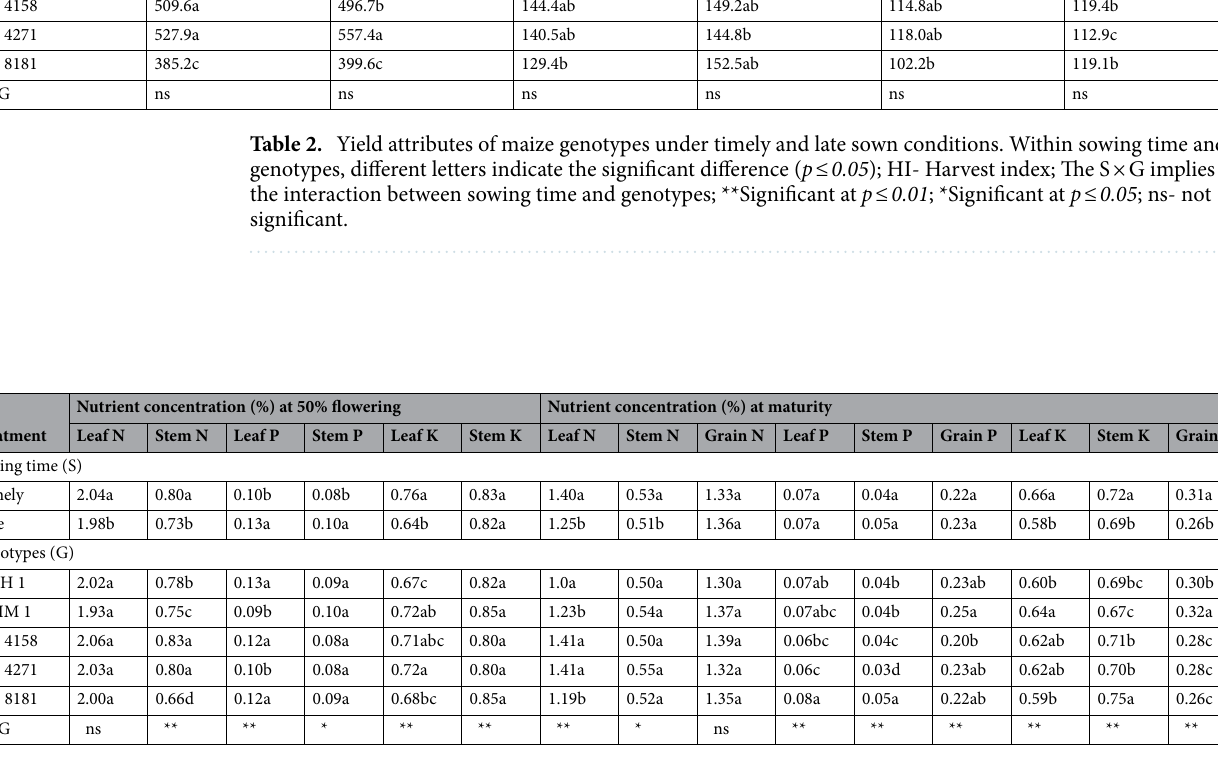
Table 3. Nutrients concentration in different plant parts of maize genotypes at 50% flowering and at maturity under timely and late sown conditions. N: Nitrogen, P: Phosphorus, K: Potassium. The nutrient concentration given in the table is the mean of 2 years (i.e., 2020 and 2021). Within sowing time and genotypes, different letters indicate the significant difference ( P ≤ 0.05); the S × G implies the interaction between sowing time and genotypes; **Significant at p ≤ 0.01; *Significant at p ≤ 0.05; ns: not